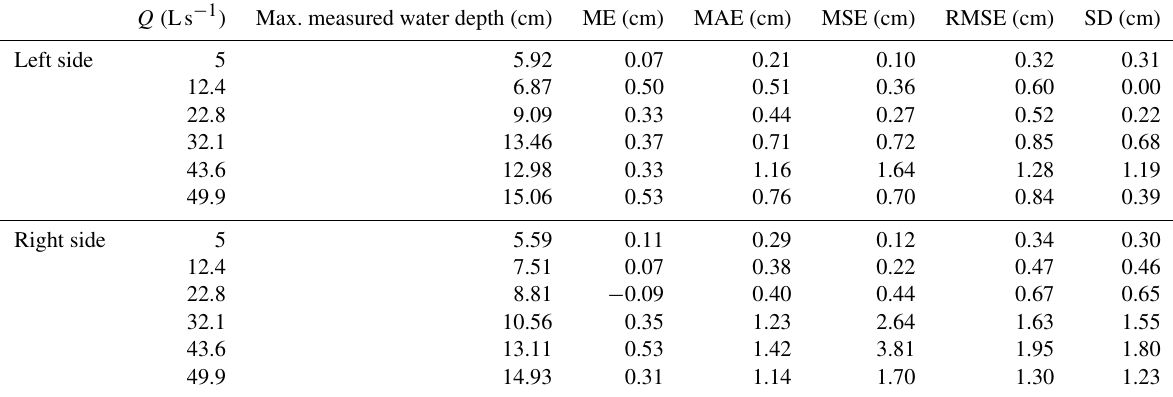
Table 1. Error indices of the simulated water surface elevations at both sides. Q (Ls − 1